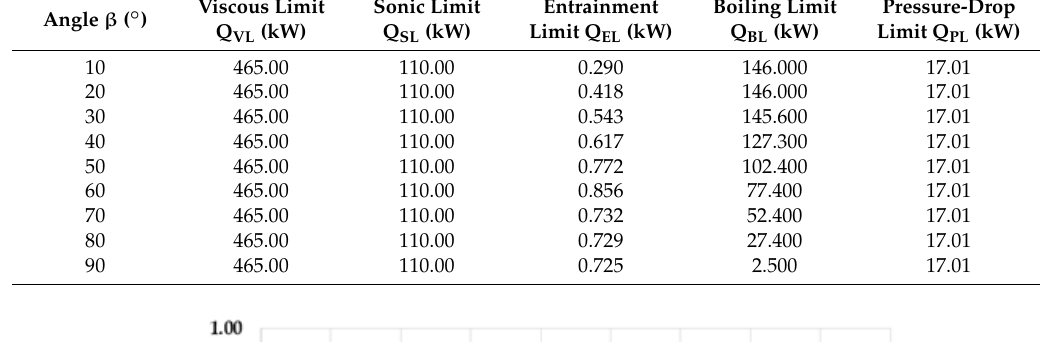
Table 6. Impact of the evaporator inclination angle.